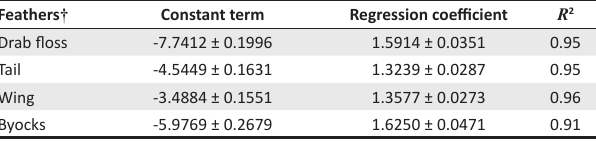
TABLE 7: Allometric coefficients relating the natural logarithms of the weighed feathers from different regions to the natural logarithms of the total feather weight. Feathers †